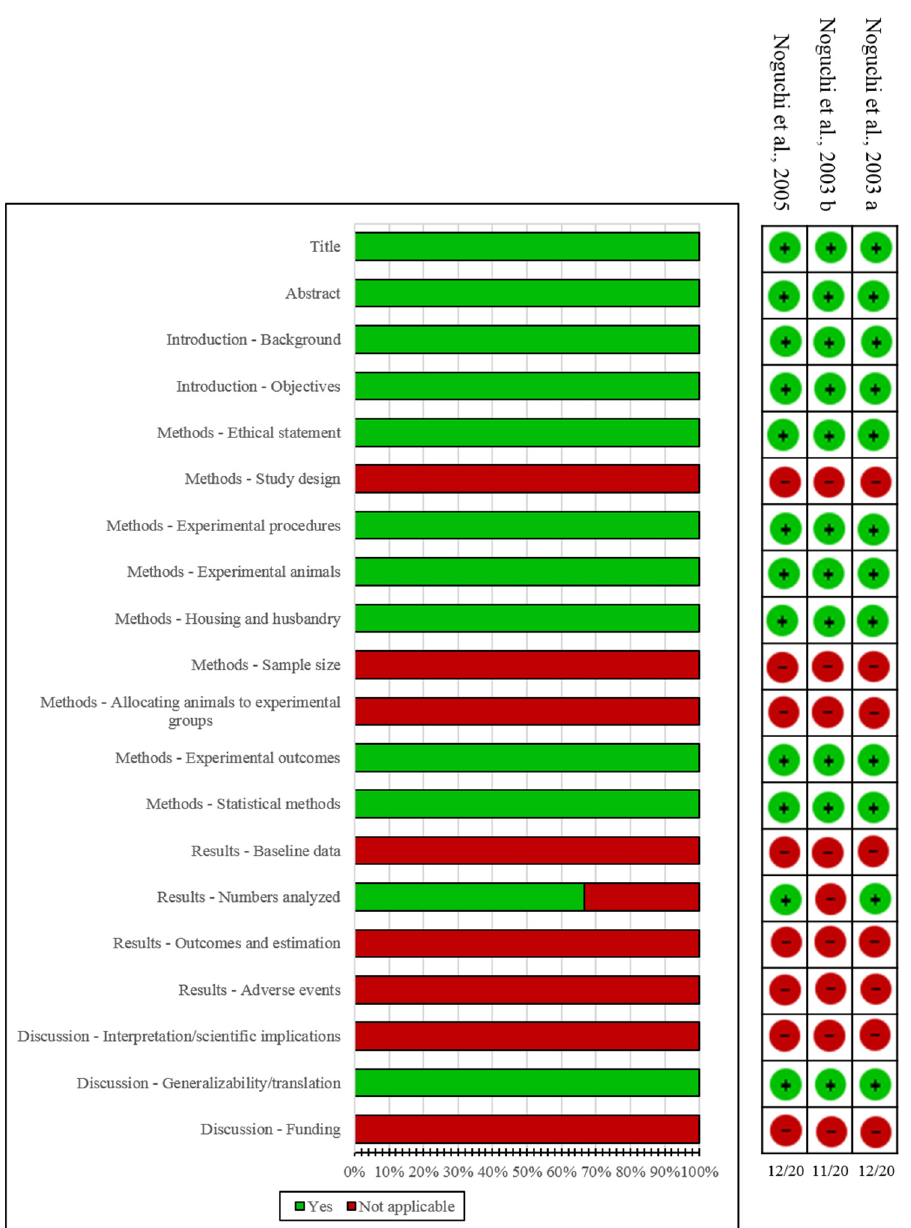
Figure 3. Quality assessment of included in vivo studies according to ARRIVE (Animal Research: Reporting of In Vivo Experiments) guideline.